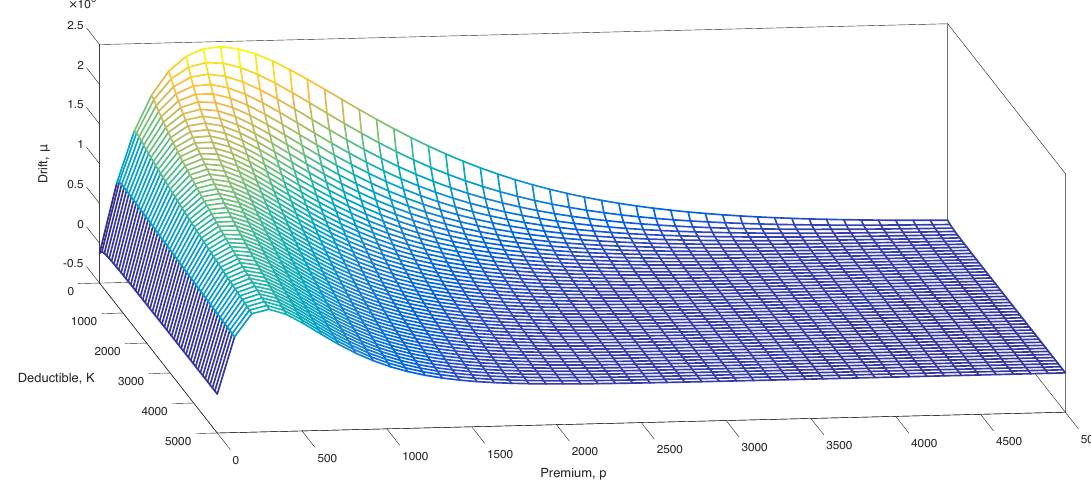
Figure 2. A mesh of the drift µ ( p ; K ) for deductibles and premiums in the range [ 0,5000